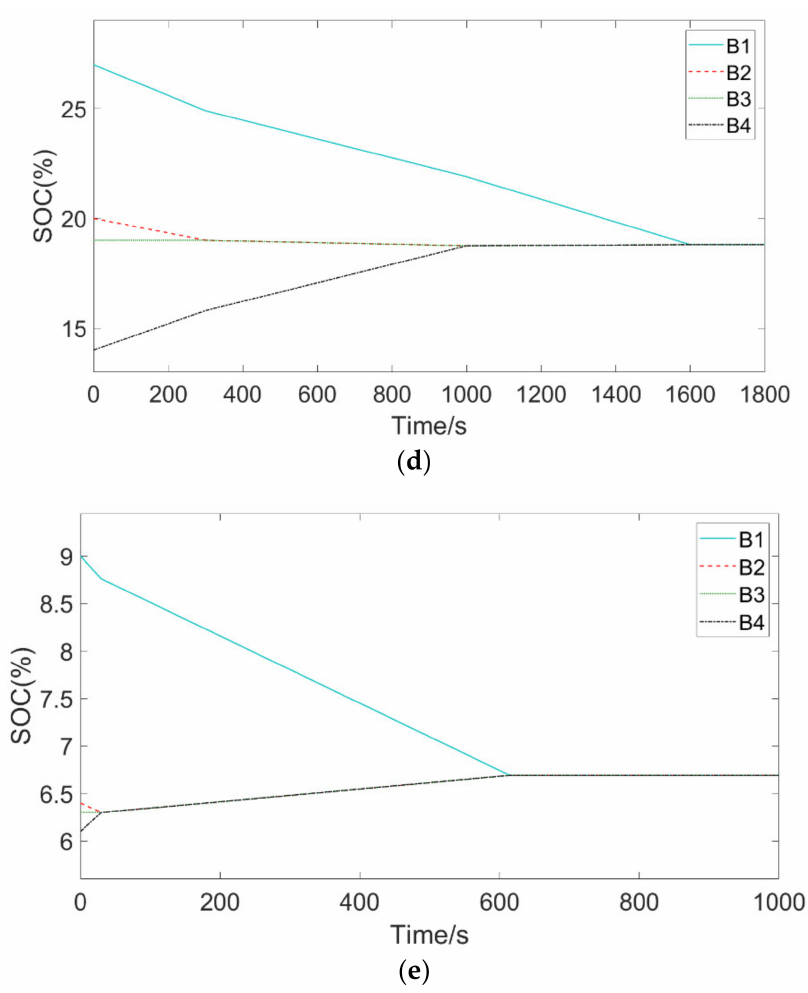
Figure 7. Battery SOC curve at different states of